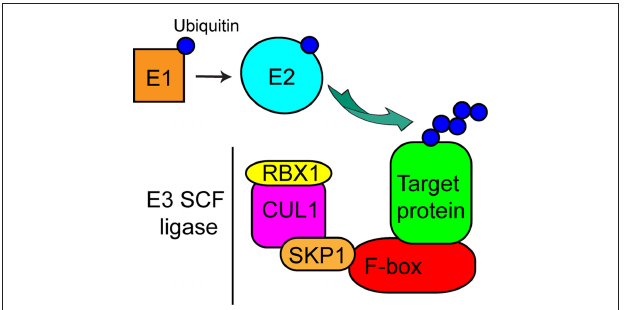
FiGure 1 | Model of the eukaryotic SCF complex. Cartoon representation of the eukaryotic SCF complex and the E1 activating and E2 conjugating enzymes. E1 transfers ubiquitin to E2, which then conjugates ubiquitin to a target protein associated with the F-box protein within the E3 SCF multi- protein